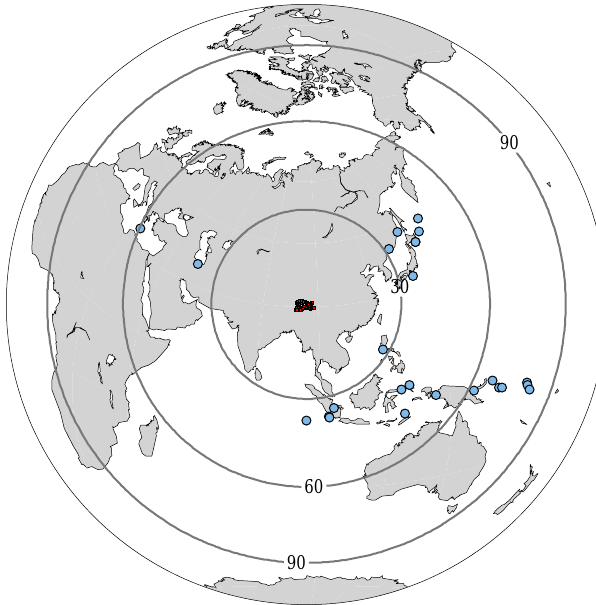
Figure 6. Epicentral distribution of teleseismic earthquakes used in the study (30–90 ◦ ). Rectangles indicate seismic stations in this